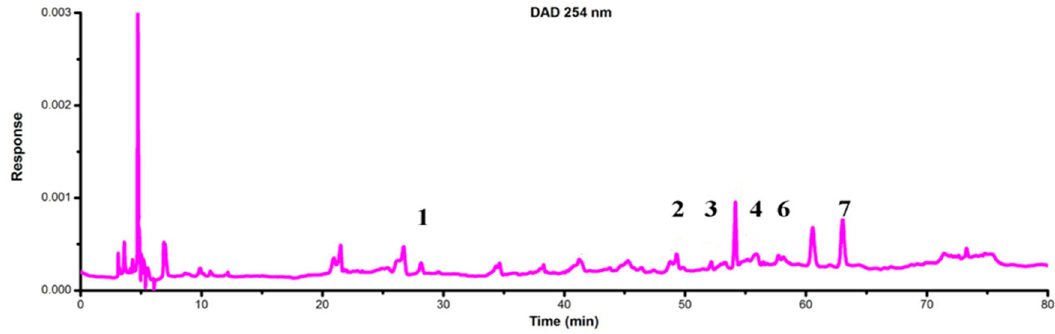
Figure 10. DAD (254 nm) chromatograms of flavonoid extract from M. polymorpha L. gametophyte .